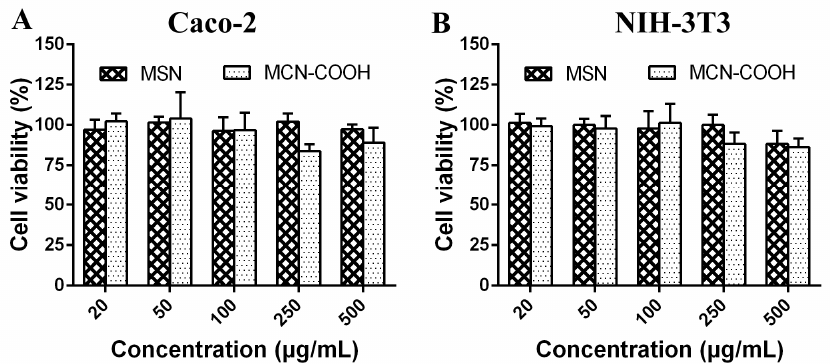
Figure 8. Effect of MSN and MCN–COOH on cell viability of ( A ) caco-2 cells and ( B ) NIH-3T3 cells by MTT assay for 24 h.